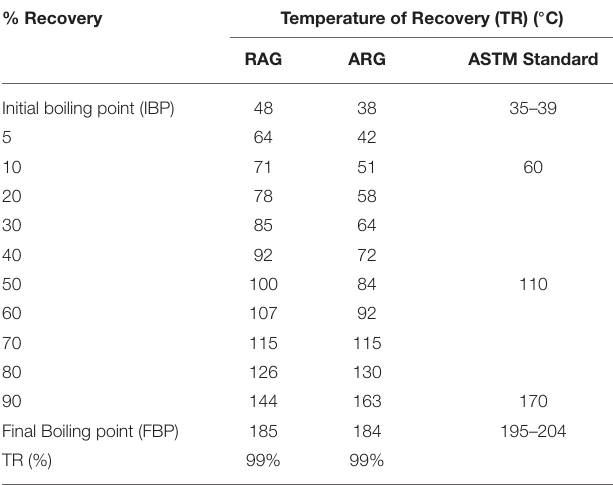
TABLE 3 | Atmospheric pressure distillation.